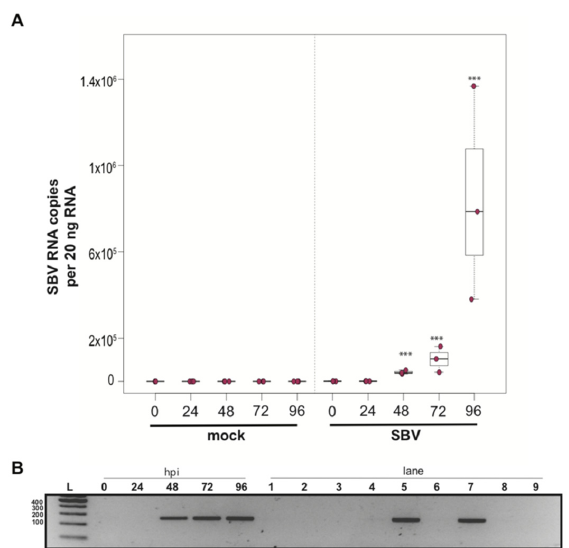
Figure 2. Sacbrood virus (SBV) replicates in primary honey bee pupal cell cultures. ( A ) SBV abun- dance was assessed in mock- or SBV-treated pupal cells by qPCR over a time course (i.e., 0 hpi, 24 hpi, 48 hpi, 72 hpi, and 96 hpi). A representative replicate of SBV-infection in pupal cells is plotted. The addition of larval lysate to pupal cells resulted in a 59× fold increase relative to 0 hpi by 48 hpi ( p < 0.0001), with subsequent increases at 72 hpi (126×, p < 0.0001) and 96 hpi (1047×, p < 0.0001). Raw data are included in Supplemental Table S3. See Supplemental Figure S2 for additional replicates. All differences in means relative to 0 hpi were assessed by a Dunnett’s test. Significance